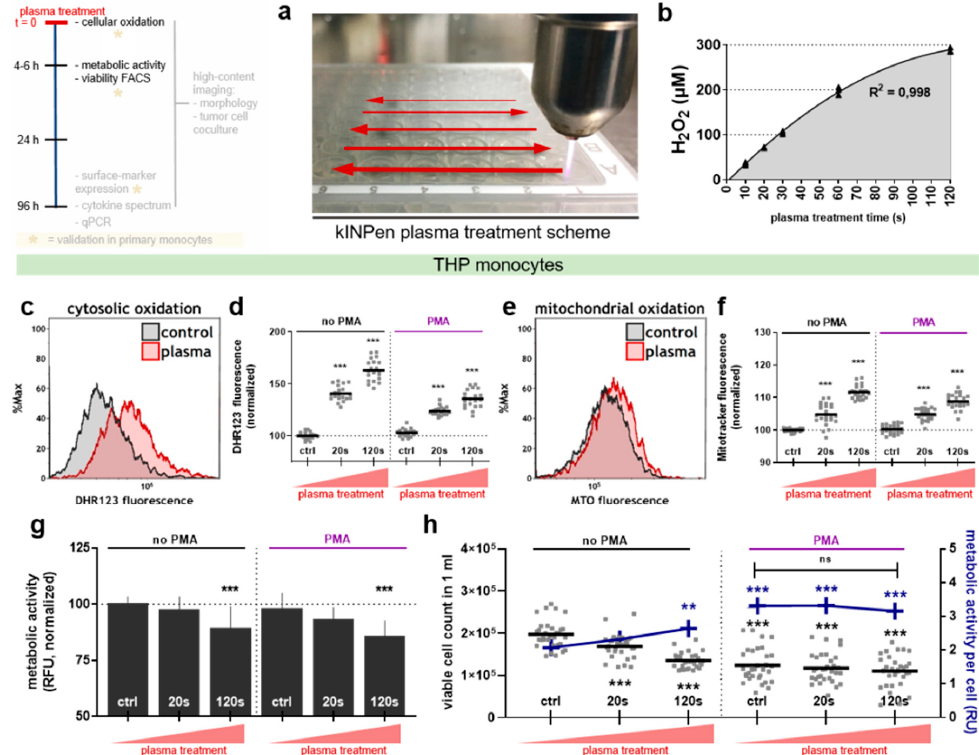
Figure 1. Exposure of THP-1 cells to physical plasma led to oxidation of cytosolic and mitochondrial compartment and altered their metabolic activity. ( a ) A schematic overview of standardized plasma treatment of a 96-well plate via a kINPen argon plasma-jet. ( b ) The concentration of hydrogen peroxide (H 2 O 2 ) after plasma treatment of 100 µL RPMI medium with goodness of fit of a polynomial (quadratic) function. ( c ) The representative overlay histogram of DHR123-stained and 120 s plasma-treated or untreated THP-1 cells without PMA and ( d ) its quantification for 0 s, 20 s and 120 s treatment time ( ± PMA). ( e ) The representative overlay histogram of MTO-stained and 120 s plasma-treated or untreated THP-1 cells without PMA and ( f ) its quantification for 0 s, 20 s and 120 s treatment time ( ± PMA). ( g ) Metabolic activity 4–6 h post plasma treatment and ( h ) the count of viable (DAPI - ) THP-1 cells in 1 mL volume, with their calculated mean metabolic activity per cell (blue data points and lines). The data (d and f) are presented as single data points (grey squares) of 4 replicates derived from six independent experiments, and their mean (black bars). The metabolic activity was determined in 8 independent experiments and is presented as ( g ) mean (bar graphs) + SD or ( h ) mean as black bar with replicates as blue boxes accompanied by the mean of activity per cell count (blue data points). The statistical analysis was performed using one-way anova with Dunnett post-testing to respective controls. Asterisks represent statistical comparison to control cells without PMA. The seconds (s) indicate plasma treatment time, ctrl = control.